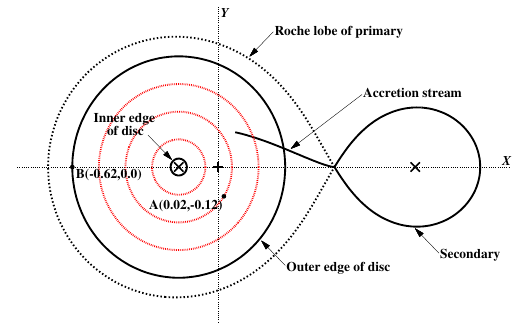
Figure 1: Co-rotating Cartesian spatial coordinate frame for a model